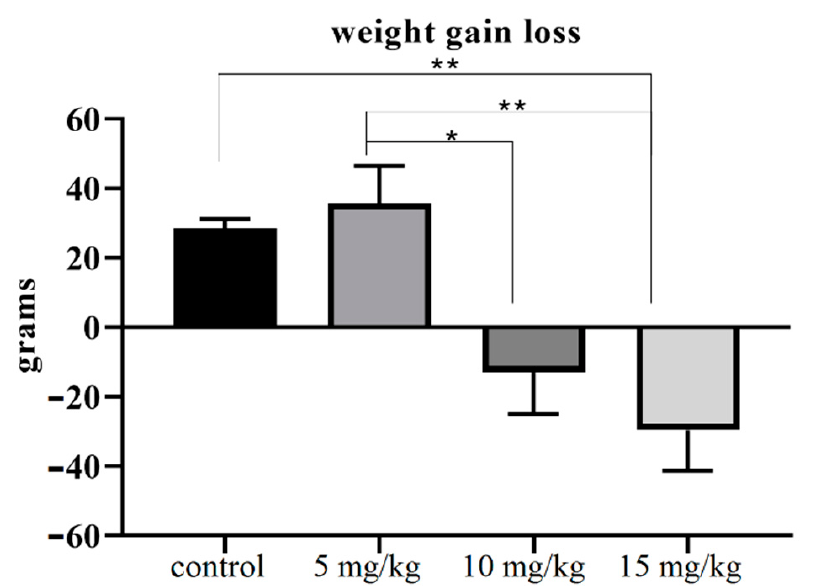
Figure 1. Mean (with SEM) weight gain/loss during animal trials, showing about 30 g decrease in